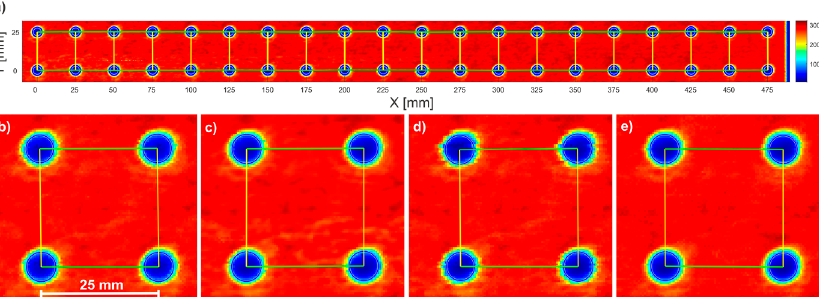
Figure 7. The C-scan of the breadboard for point-by-point without averaging scheme ( a ) and C- scans of first four spots for following schemes: point-by-point without averaging ( b ), point-by-point averaging 100 ( c ), line-by-line without averaging ( d ), and line-by-line averaging 100 ( e ). To compare the C-scans, we quantified the uniformity of spot distribution. For each